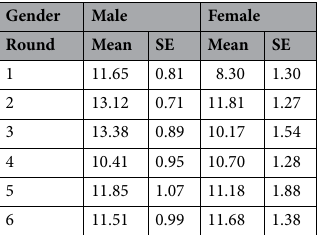
Table 2. Equilibrium price by rounds and gender. SE standard